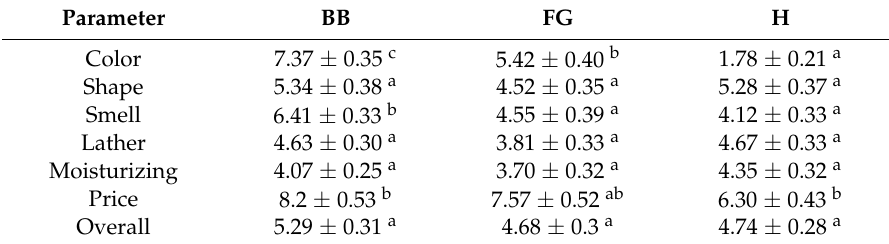
Table 3. Sensory attributes of different commercial natural soaps manufactured using cold saponification.